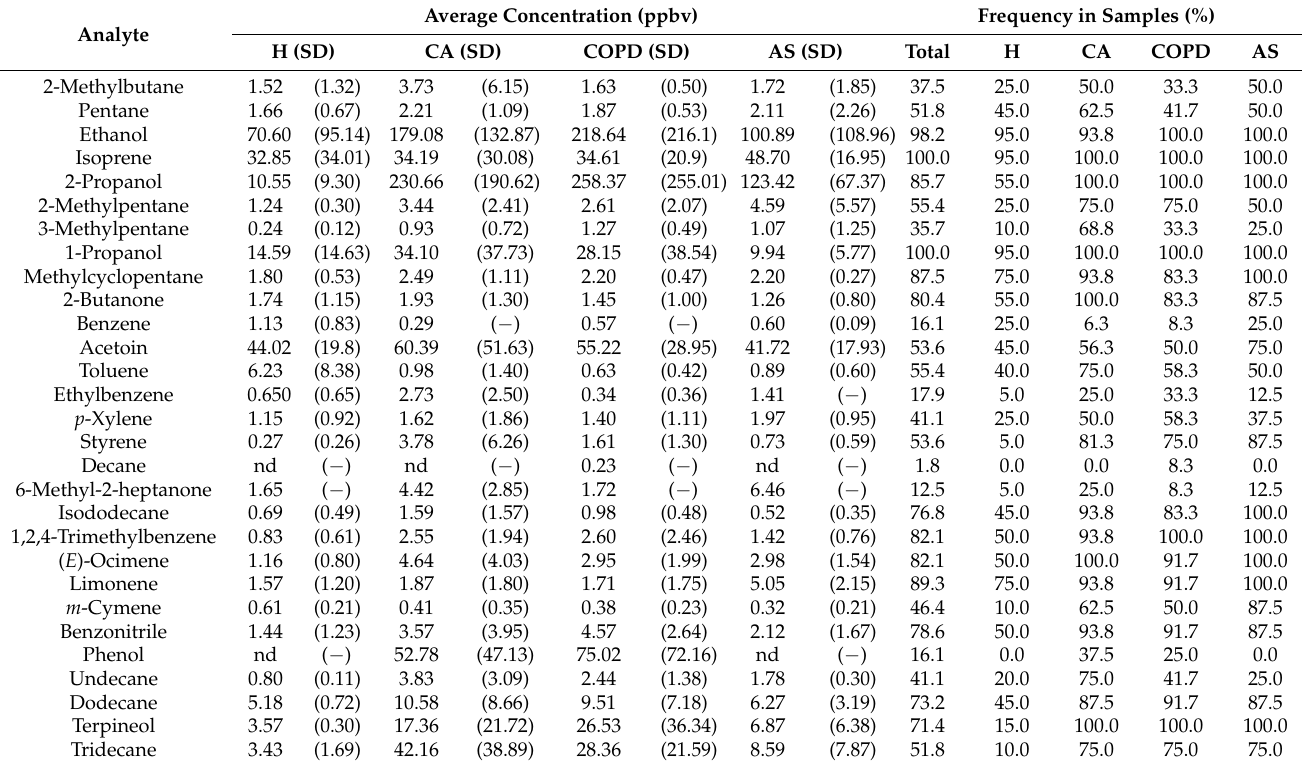
Table 1. Data regarding quantitation of the targets in breath samples (H = healthy, CA = lung cancer, COPD = chronic obstructive pulmonary disease, AS = asthma, SD = standard deviation, nd = not detected, ( − ) = SD not calculated because analyte was quantified just in a single sample, nd = not detected). Average Concentration (ppbv) Analyte